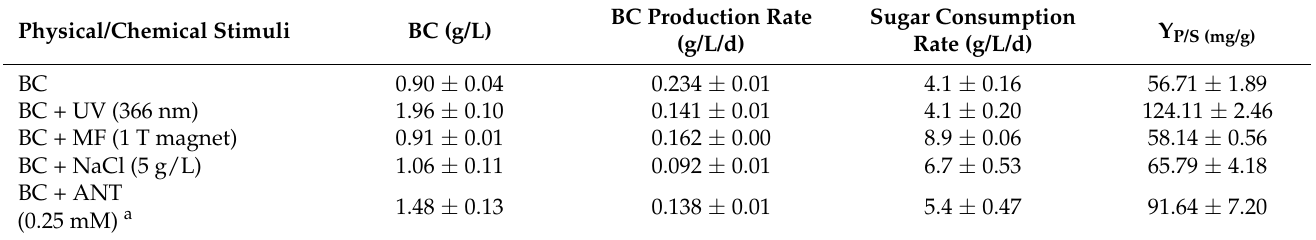
Table 2. Kinetic parameters for BC production by K. xylinus exposed to physical and chemical stimuli in static culture (HS